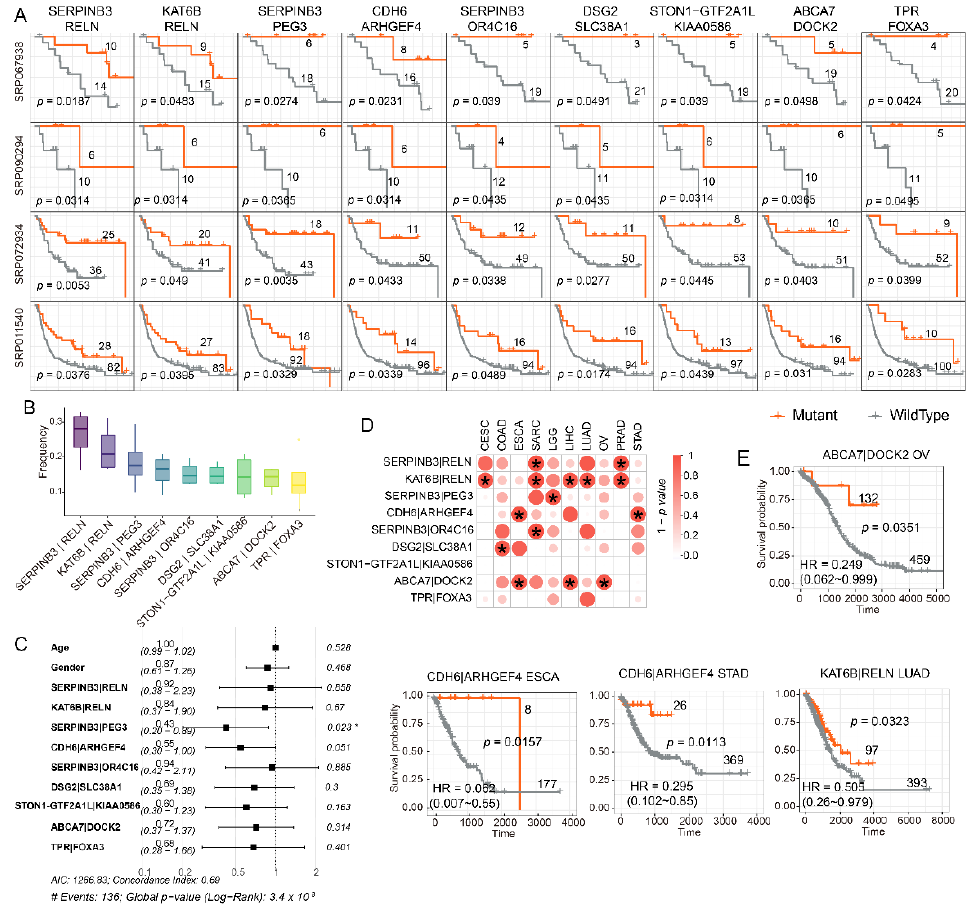
Figure 3. The mutation of gene pairs significantly associated with patient survival. ( A ). Kaplan–Meier curves showing the mutation of 9 pairs of genes associated with longer survival in four independent melanoma datasets. p -value was measured by log-rank test. ( B ). Boxplots showing the mutation frequencies of survival-related gene pairs. ( C ). Forest plot showing log hazard ratios (HR) and their 95%-confidence intervals of survival-related gene pairs and clinical indicators (including age and gender) by cox regression analysis. The p -value comes from testing the null hypothesis of hazard ratio 1. ( D ). Dot plot showing the effect of survival-related gene pairs on patient survival in TCGA cancer samples. “*” indicates a log rank test p -value < 0.05. ( E ). Kaplan–Meier curves showing gene pairs as an independent risk factor in TCGA cancer samples (Likelihood ratio test < 0.05 in cox regression analysis).